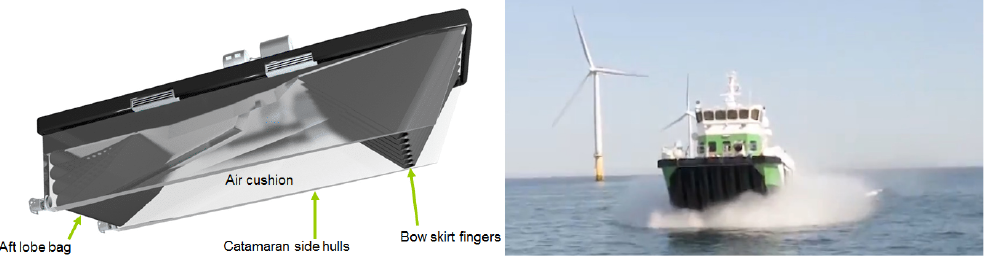
Figure 3. Catamaran with an air cushion [27].